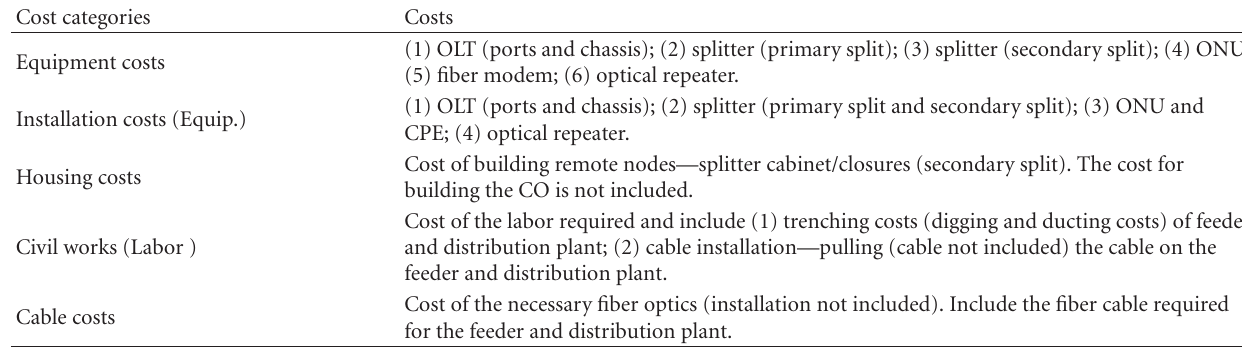
Table 6: FTTH (PON) architecture components by category.